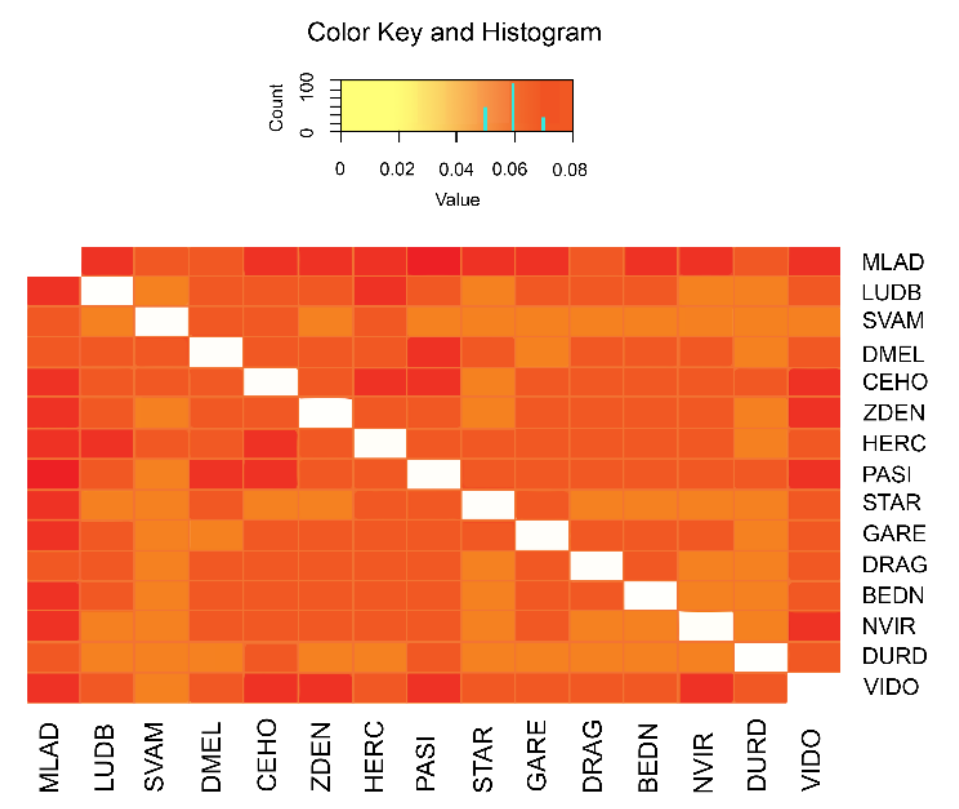
Figure 3. The range of the fixation index (F ST ) between Colorado potato beetle populations in Croatia. Table 3. Analysis of molecular variance (AMOVA) using 7681 SNPs of the genetic variation among and within CPB